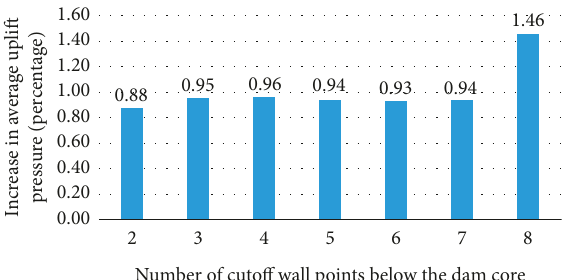
Figure 10: Percentage increase in average uplift pressure.